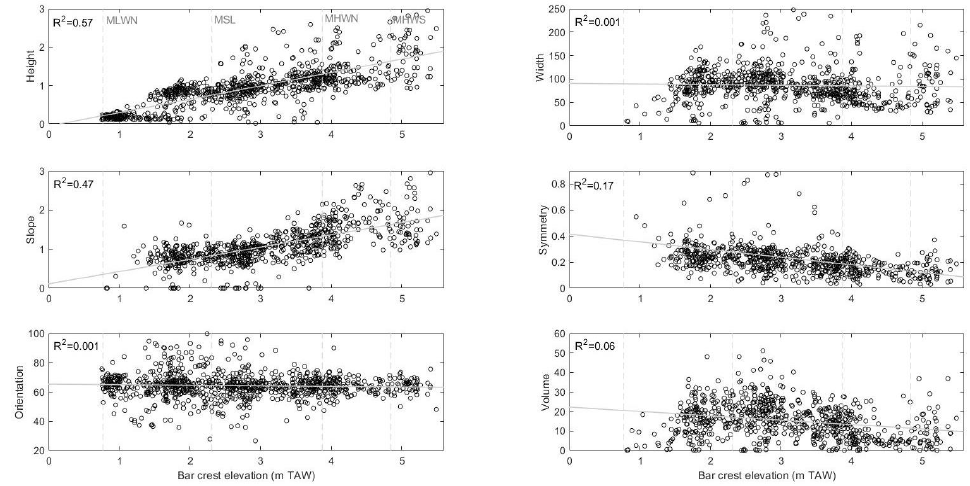
Figure 8. Correlations between morphometric parameters characterizing the bar morphology. The vertical dashed lines correspond to the tidal levels. ( p < 0.05).